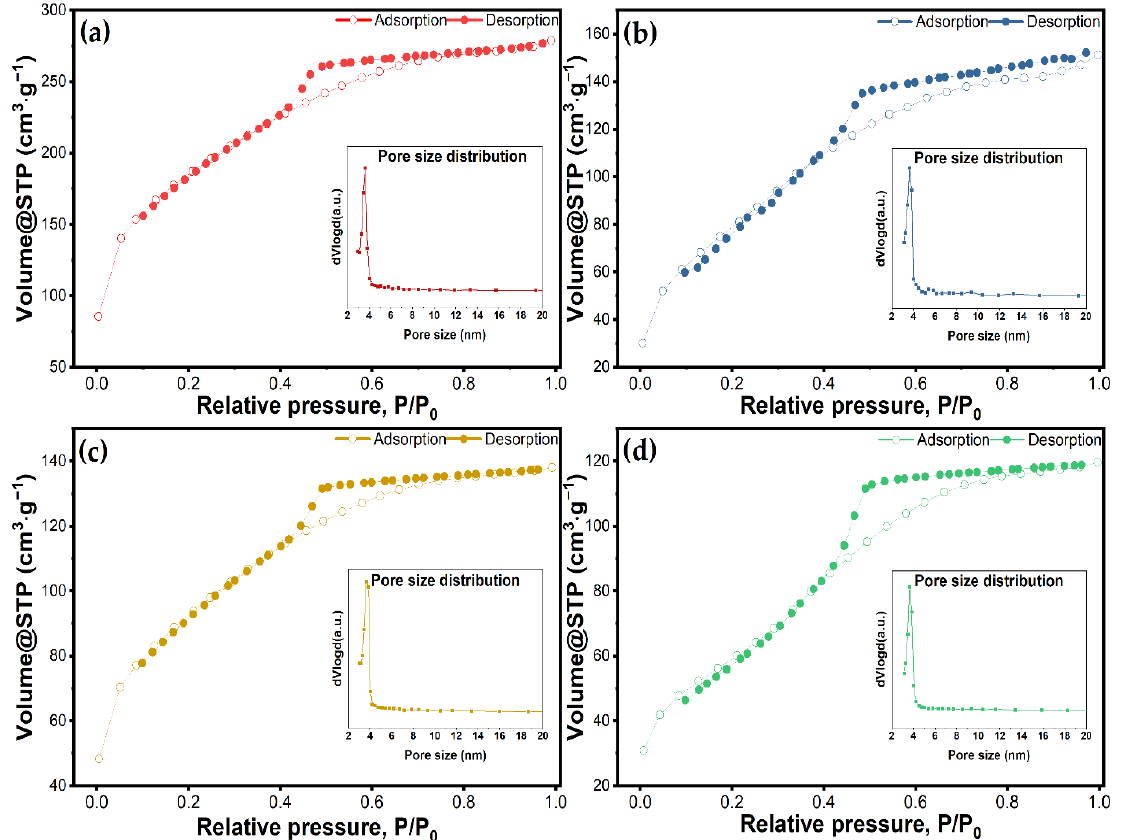
Figure 4. N 2 adsorption/desorption isotherms and corresponding pore size distributions for ( a ) unloaded MSM, and loaded MSMs by ( b ) physical mixing, ( c ) solvent evaporation, and ( d ) vacuum-assisted